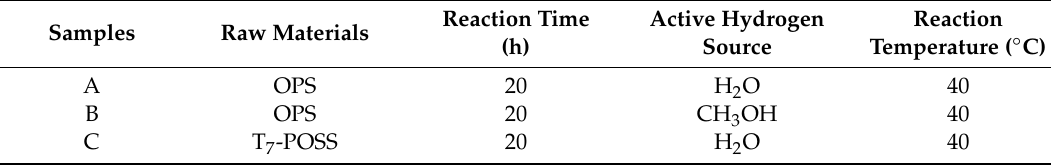
Table 1. The preparation of POSS-based porous